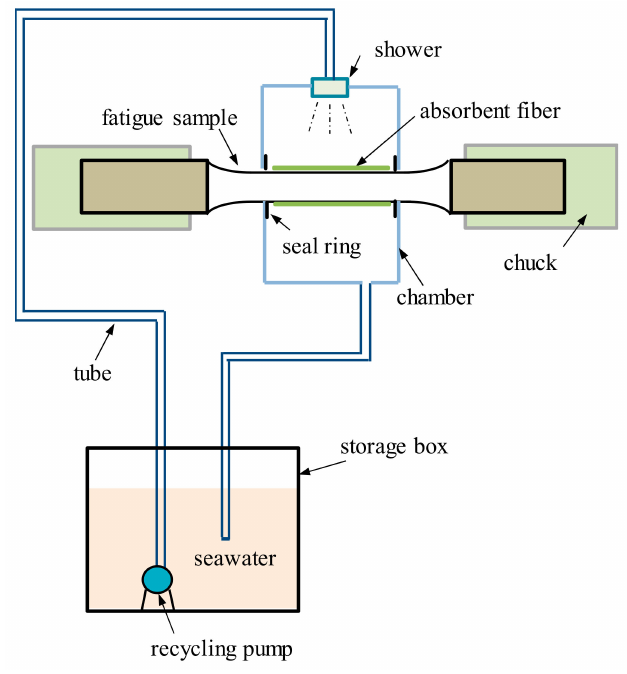
Figure 4. Setup of circulation device of corrosion solution matching with fatigue testing